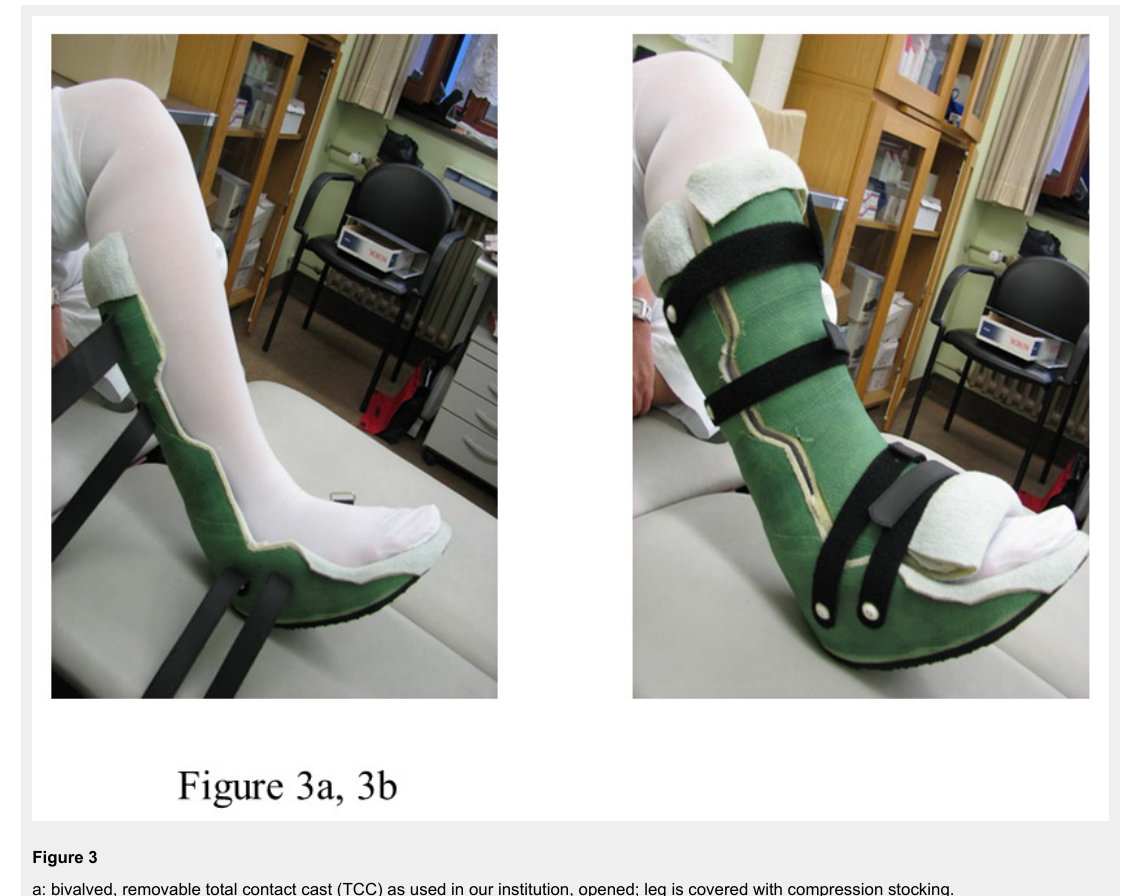
a: bivalved, removable total contact cast (TCC) as used in our institution, opened; leg is covered with compression stocking. b: TCC